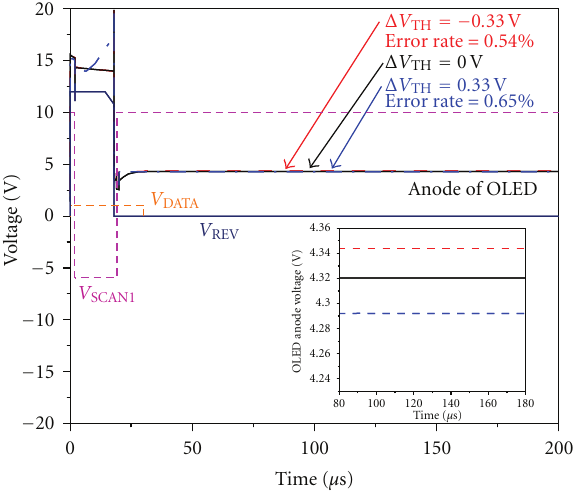
Figure 5: Gate, source, and drain voltage of driving TFT (DTFT) with operation stages when V DATA = 5V.